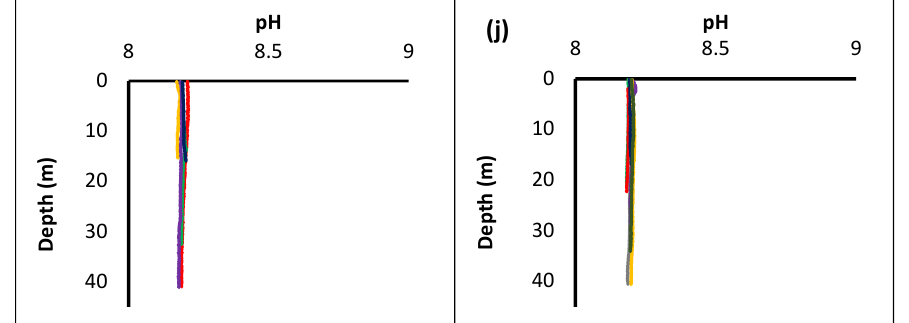
Figure 4. Depth profiles of five physicochemical parameters: temperature ( a ), Chl-a ( c ), oxygen ( e ) salinity ( g ) and pH ( i ), concentrations in the stations where sea cucumbers were found and depth profiles of temperature ( b ), Chl-a ( d ), oxygen ( f ), salinity ( h ) and pH ( j ), concentrations in the stations where sea cucumbers were absent.